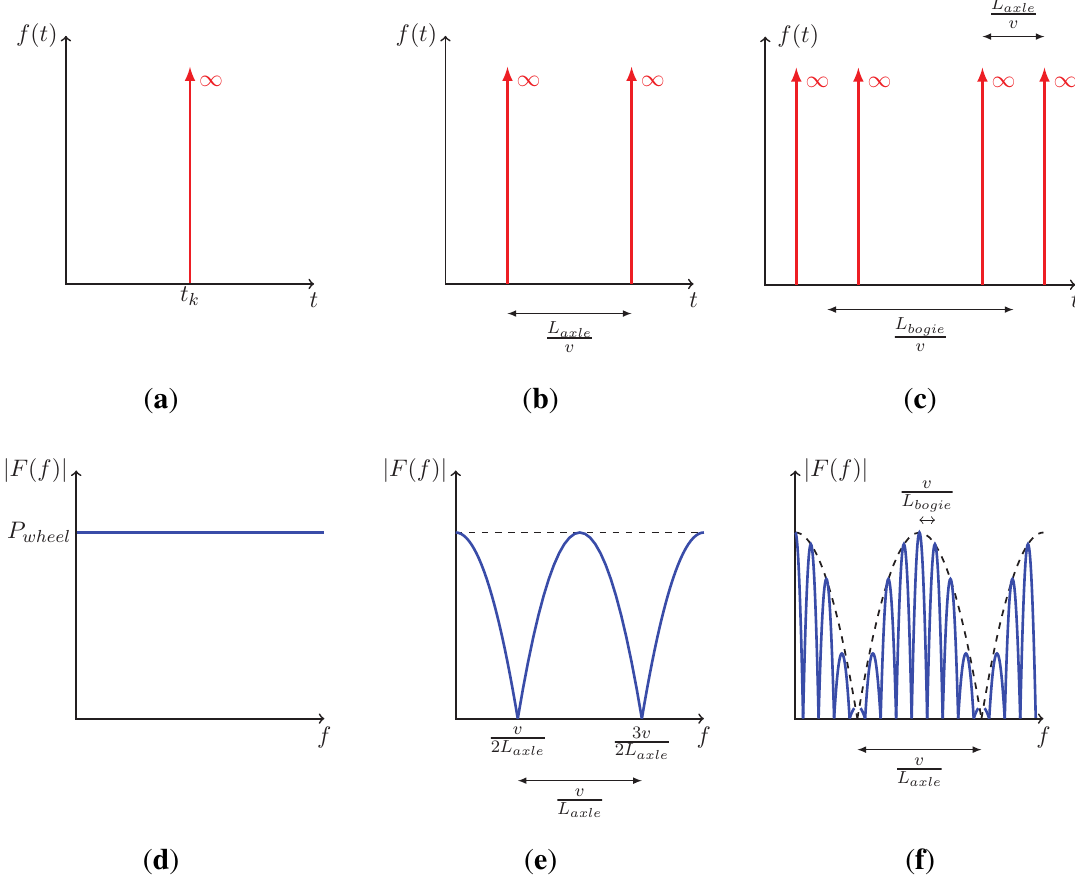
Figure 4. Carbody effect with Dirac functions. ( a ) Single Dirac function—one wheel effect (time history); ( b ) Double Dirac function—two wheels effect (time history); ( c ) Quadruple Dirac function—four wheel effects (time history); ( d ) Single Dirac function—one wheel effect (frequency content); ( e ) Double Dirac function—two wheels effect (frequency content); ( f ) Quadruple Dirac function—four wheel effects (frequency